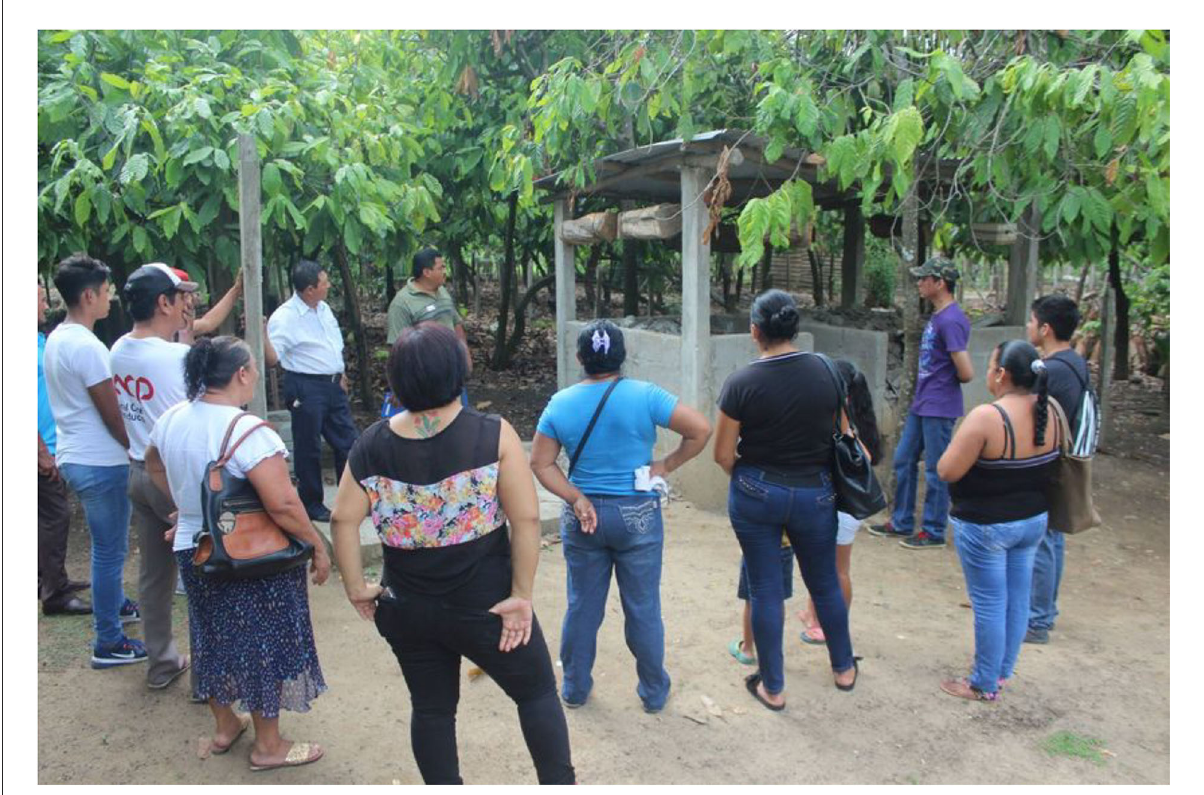
FIGURE2 Community agroecological workshops in Zapotal, Comalcalco,